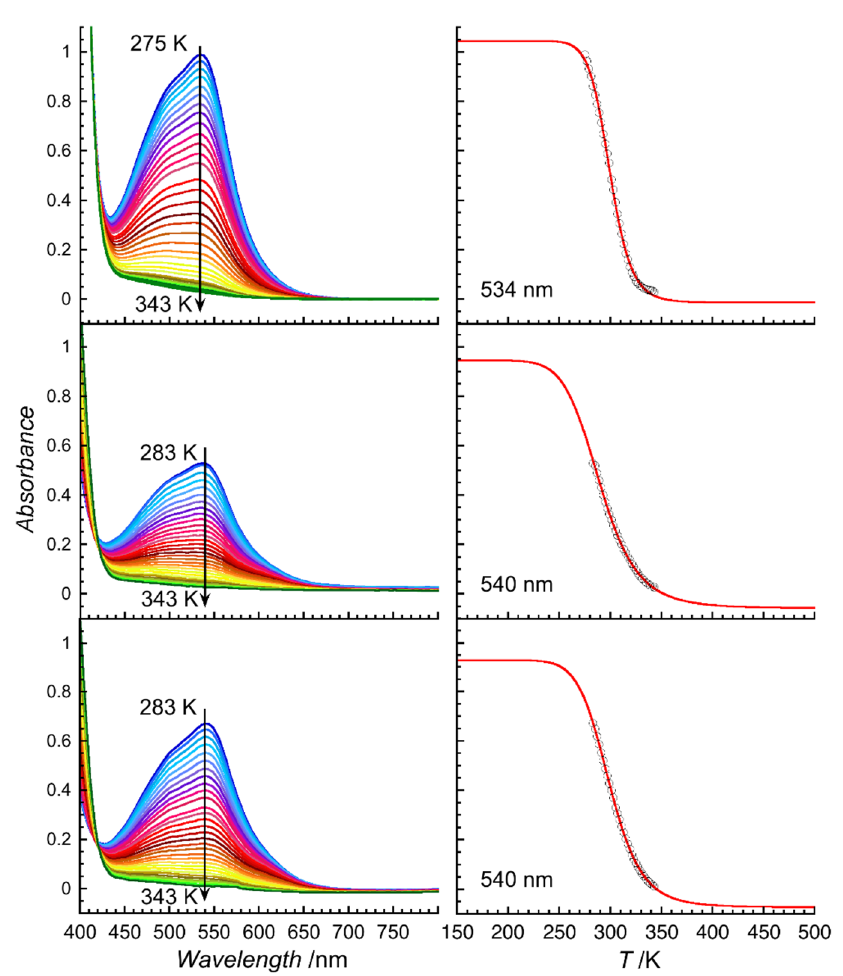
Figure 4. Temperature dependence of the UV-visible (UV-Vis.) spectra between 400–800 nm (left) and of the maximum absorption (right) at 534 nm (complex 3 , top) and 540 nm (complex 4 , middle, and complex 5 , bottom) in acetonitrile solution.